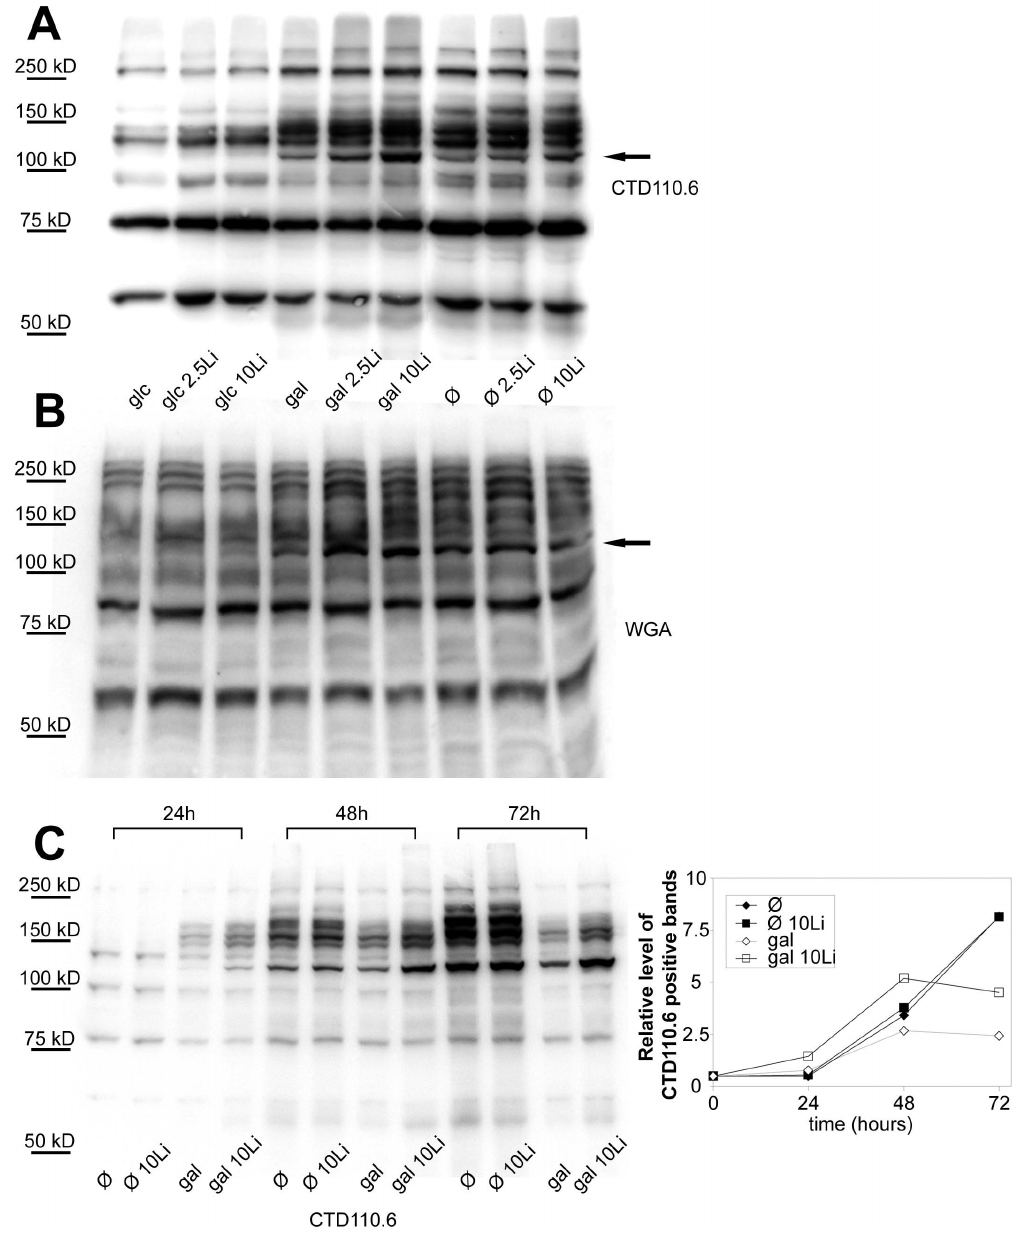
Figure 7. The elevation of O-GlcNAc (CTD110.6-positive) proteins in lithium treated, galactose-grown cells is similar to those of fasting cells. ( A ) Western-blot analysis using CTD110.6 antibody and ( B ) peroxidase-conjugated lectin (WGA) staining (bottom) shows representative samples of protein extracts from Jurkat cells previously incubated for 48 hours in 5 mM glucose, 5 mM galactose or hexose-free media, supplemented with either 0, 2.5 or 10 mM lithium. ( C ) Left: Representative western-blot analysis using CTD110.6 antibody (top) shows Jurkat samples previously starved or incubated in 5 mM galactose containing media, with or without 10 mM lithium. Cellular extracts were isolated on the 1 st , 2 nd and 3 rd day of the experiment. Right: Densitometric analysis of the total CTD110.6 staining over time. Levels are expressed as a percentage of the baseline intensity. Each data point represents the average of at least 3 separate experiments. In the same order as the samples are presented on the blot from left to right, the numerical mean 6 SD values are: 0,71( 6 0,05); 0,79( 6 0,08); 1,06( 6 0,03); 1,74( 6 0,03); 3,59( 6 0,40); 4,02( 6 0.47); 2,83( 6 0.14); 4,95( 6 0.29); 7,88( 6 1.44); 7,95( 6 1.50); 2,26( 6 0.30); 3,96( 6 1.26), respectively.